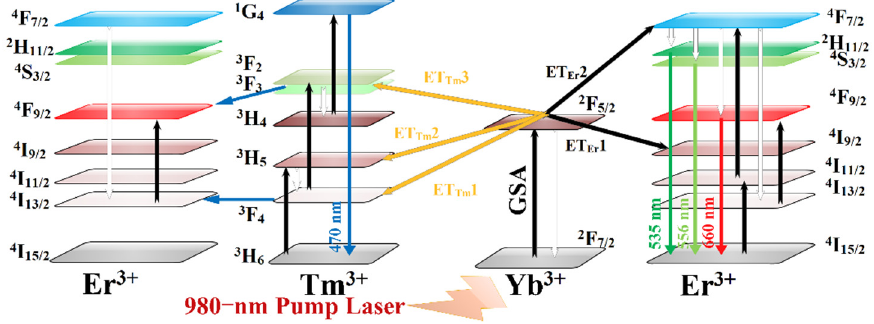
Figure 8. Y 2 O 3 -ZnO:Yb 3+ /Er 3+ /Tm 3+ -tridoped nano-phosphor UC energy transfer mechanisms.